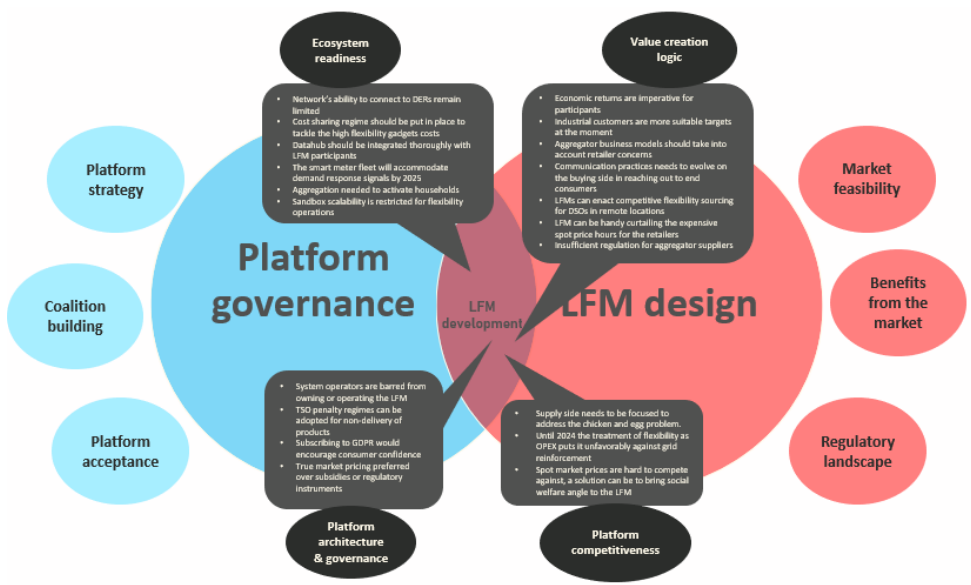
Figure 5. The modified theoretical framework, with the critical impact areas in LFM development.